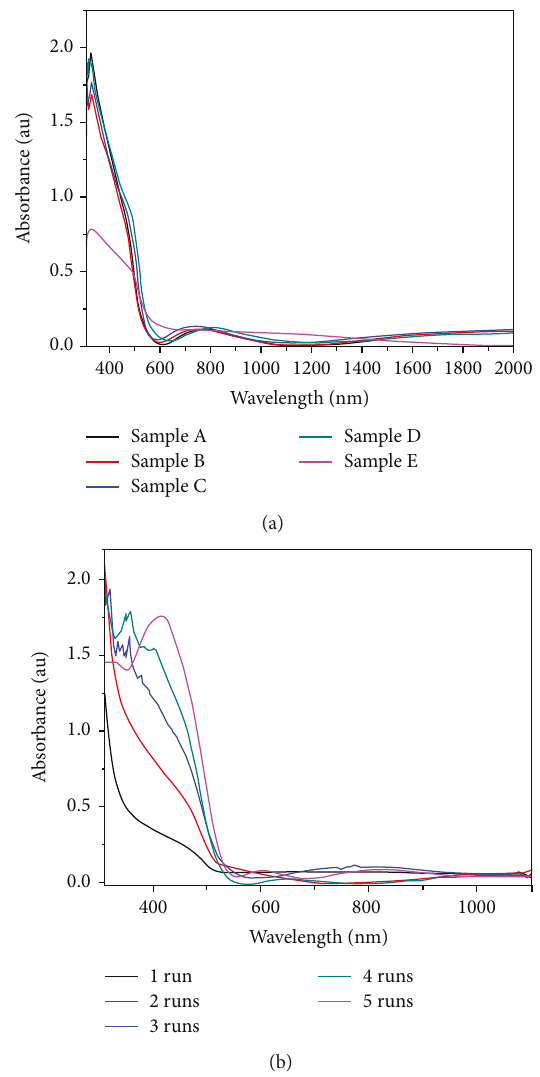
Figure 10: The absorbance spectra of (a) the as deposited and annealed fi lms and (b) the fi lms deposited in di ff erent numbers of